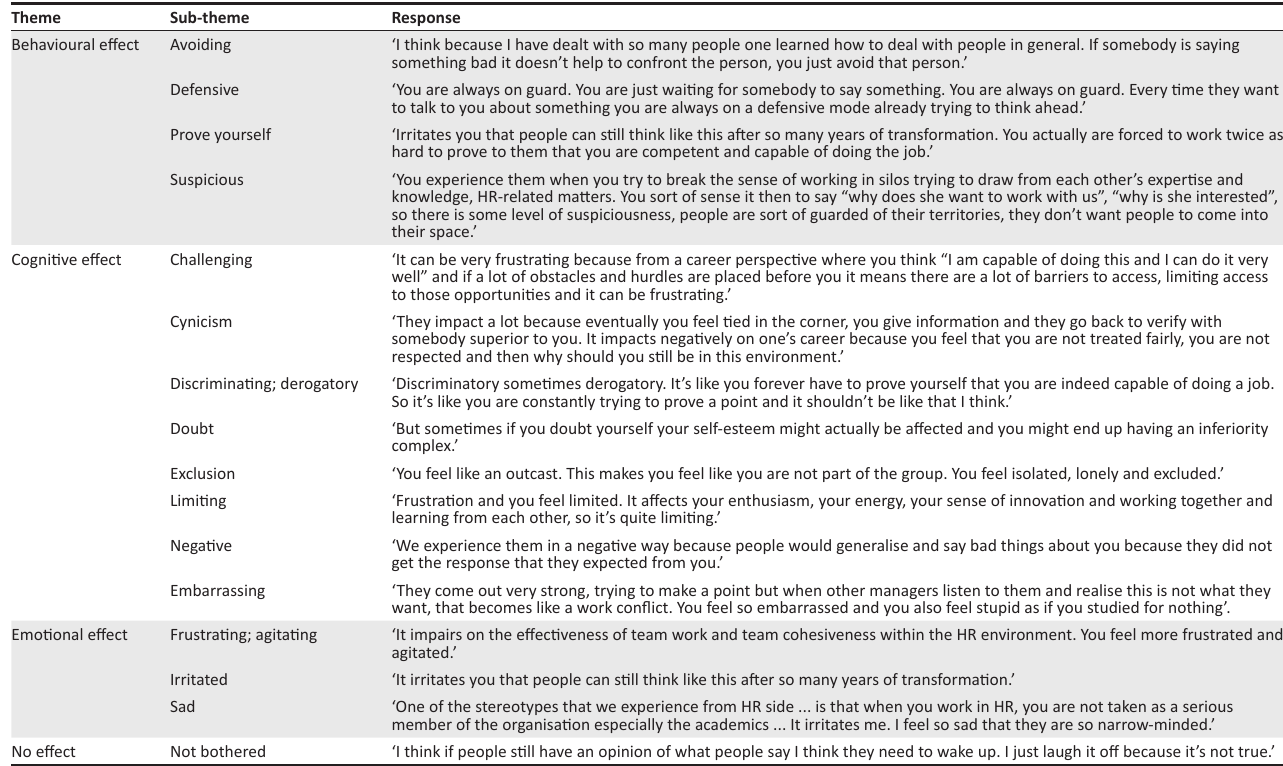
TABLE 2: Experience of